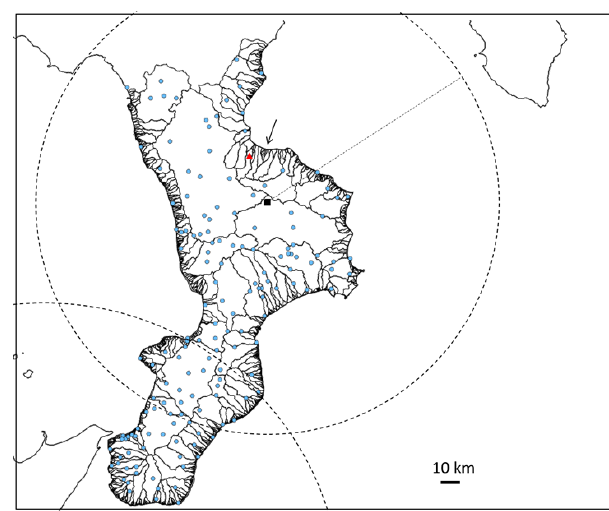
Figure 1. Rain-gauge network and Mount Pettinascura weather radar (black square) with its optimal operative range. The arrow indicates the studied catchment, and the red triangle the nearest rain gauge. The operative range of the Monte Lauro weather radar, in Sicily, is also